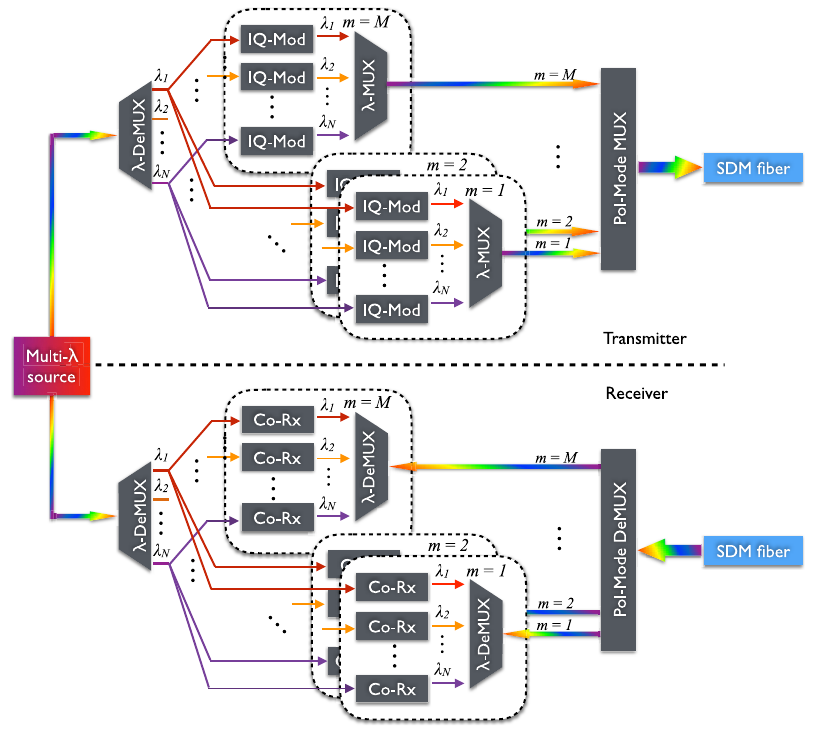
Figure 3: Schematic of an envisioned SDM-WDM transceiver system that sup- ports N wavelengths × M spatial paths in a fi ber link. The arrows indicate the optical signal fl ows. For example, the transmission capacity can reach 1.2 Pb/s using 120 wavelength (covering C and L bands) times 10 spacial modes at 1 Tb/s per channel (e.g., 100 Gbaud DP-64QAM with a 20% forward error correction (FEC) overhead).